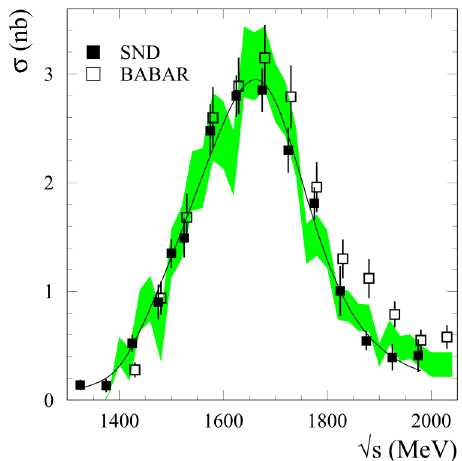
Figure 4. The cross section for the process e + e − → K S K L π 0 measured by SND (filled squares) in comparison with the BABAR data [15] (open squares). The curve represents the result of the fit to SND data with the VMD model. The band represents the prediction for the e + e − → K S K L π 0 cross section obtained using isospin relations from the BABAR measurements of the e + e − → K S K ± π ∓ , e + e − → K + K − π 0 , and e + e − → φπ 0 cross sections [13].